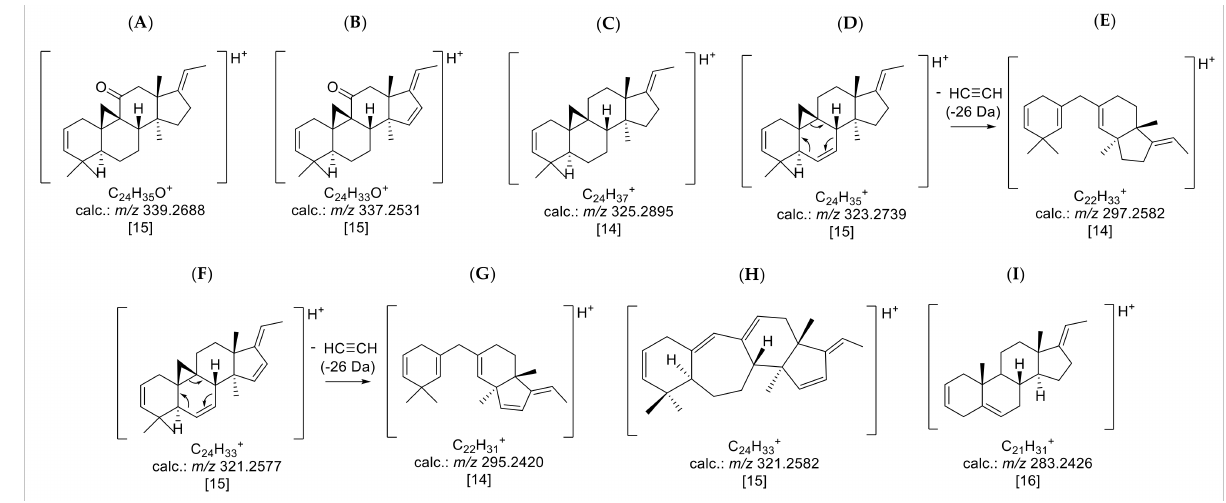
Figure 4. Prominent core fragments of the investigated nor -triterpene alkaloids of the nor -cycloartane type from B . sempervirens : ( A ) core fragment m/z 339 for fully saturated C-3/C-20 diamines with a ketone substituent; ( B ) core fragment m/z 337 for C-3/C-20 diamines with a ketone substituent possessing one additional substitution or double bond; ( C ) core fragment m/z 325 for fully saturated C-3/C-20 diamines; ( D ) core fragment m/z 323 for C-3/C-20 diamines possessing one additional substitution or double bond; ( E ) core fragment m/z 297 for C-3/C-20 diamines with a ∆ 6 ; ( F ) core fragment m/z 321 for C-3/C-20 diamines doubly substituted or unsaturated; ( G ) core fragment m/z 295 for C-3/C-20 diamines with a ∆ 6 and one further substitution or unsaturation; ( H ) core fragment m/z 321 for C-3/C-20 diamines of (9-(10 → 19))abeo-5 α -pregnane possessing one additional substitution or double bond; ( I ) core fragment m/z 283 for steroidal alkaloids with a C-3/C-20 substitution possessing one additional double bond or substitution. The postulated positions of unsaturation and substitution are based on the already known structures of compounds 19 , 22 and 26 [3,17] .